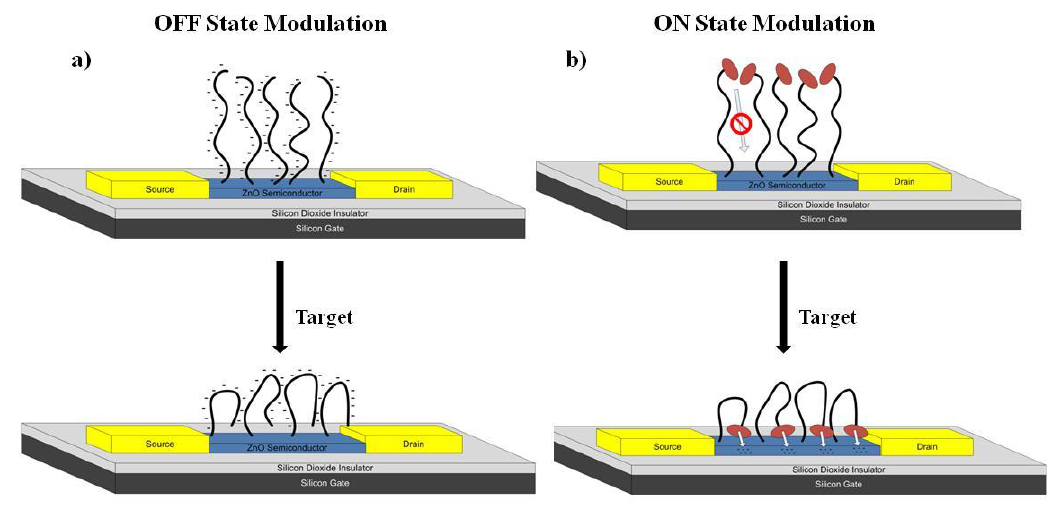
Figure 1. Schematic of aptamer binding conformation and transduction mechanism for: ( a ) OFF state AptaFET, ( b ) ON state current modulation along with corresponding aptamer conformation change upon target